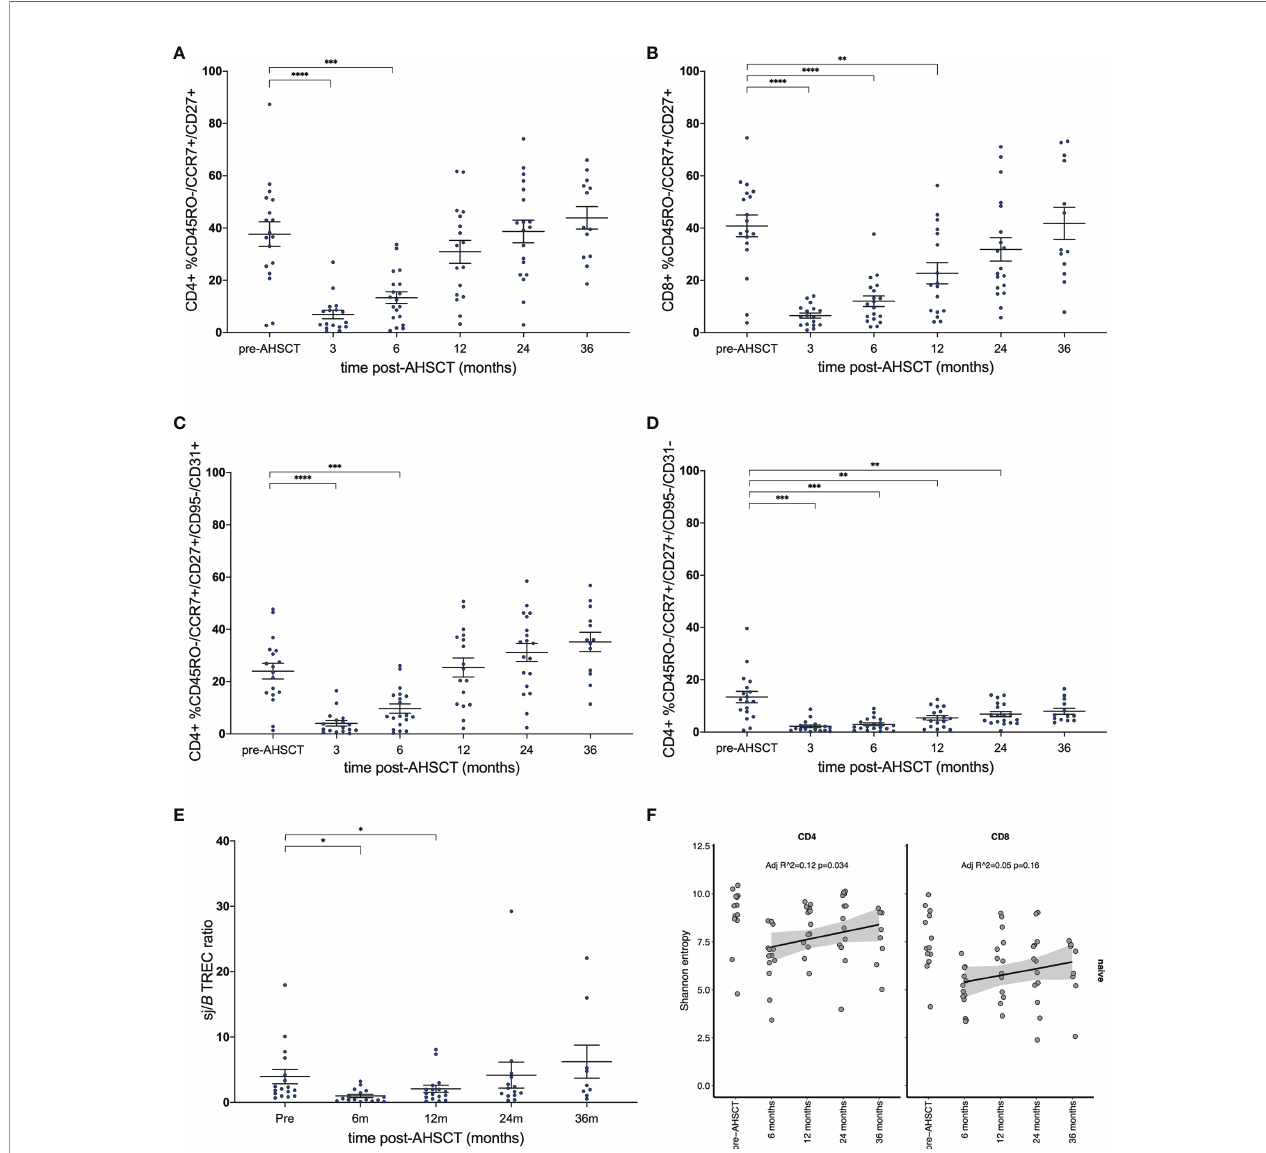
FIGURE 6 | Reconstitution of nai ̈ ve T-cell subsets. (A) CD4+ and (B) CD8+ nai ̈ ve T-cell populations prior to and following AHSCT. (C) CD4+ T lymphocytes with signatures of recent thymic egress (CD31+) drive the recovery of CD4+ nai ̈ ve populations, whilst (D) non-RTE nai ̈ ve T-cells remain below baseline up to the 36- month time point. (E) Longitudinal sj/ b TREC ratios in patients pre- and post-AHSCT. (F) Clonal diversity as measured by Shannon entropy in the CD4+CD45RA+ population (left) and CD8+CD45RA+ (right). (A – E) Bar/error bar denotes median and inter-quartile range. (A – D, F) A linear model was used to detect signi fi cance (p <0.05) between each time point with the pre-transplant (control) sample. (E) Wilcoxon signed-rank test was used to compare all time points to baseline. Holm- Sidak ’ s multiple comparison test applied. *p < .05, **p < 0.025, ***p < 0.005, ****p <